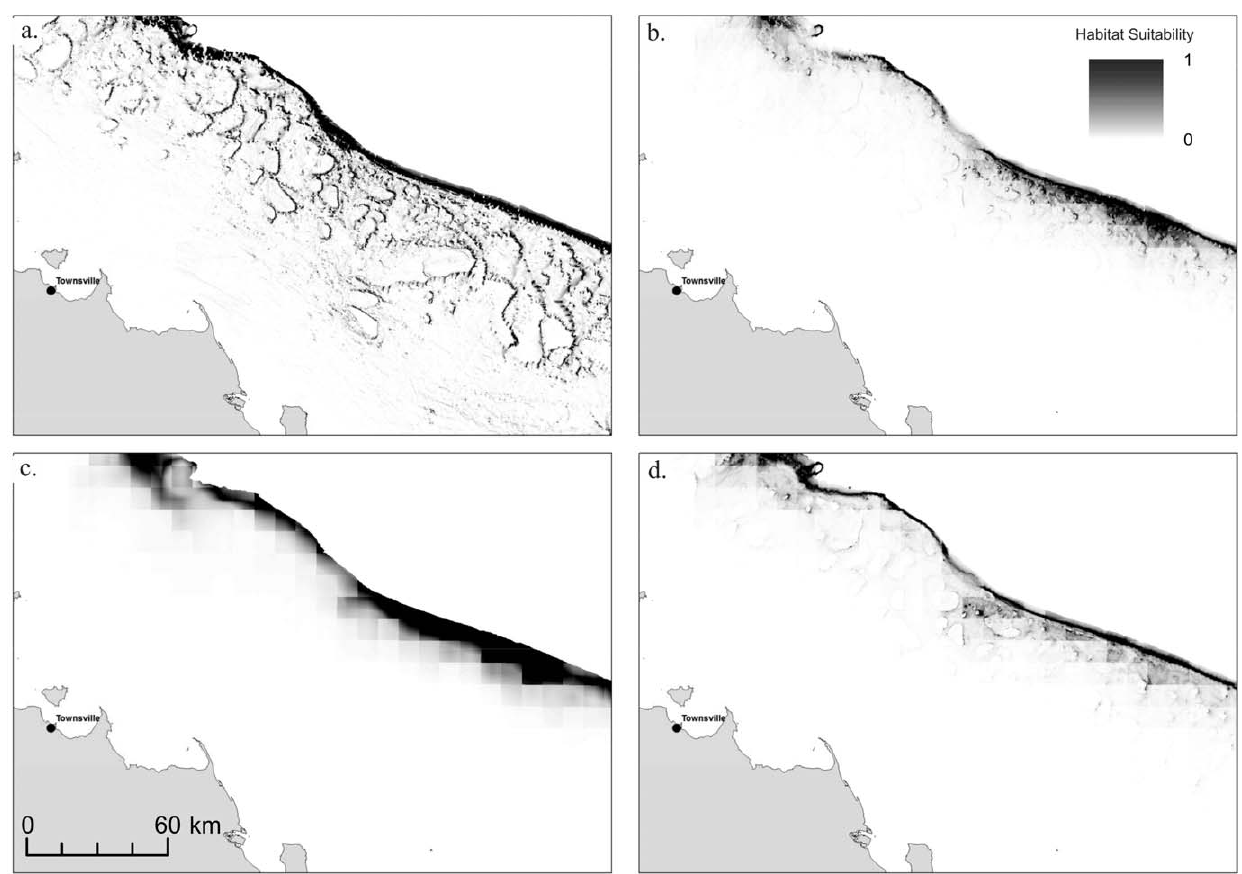
Figure 5. Habitat suitability models for heterotrophs for a section of central Great Barrier Reef. (a) GEO; (b) GEO-ENV; (c) ENV; and (d) BEST.